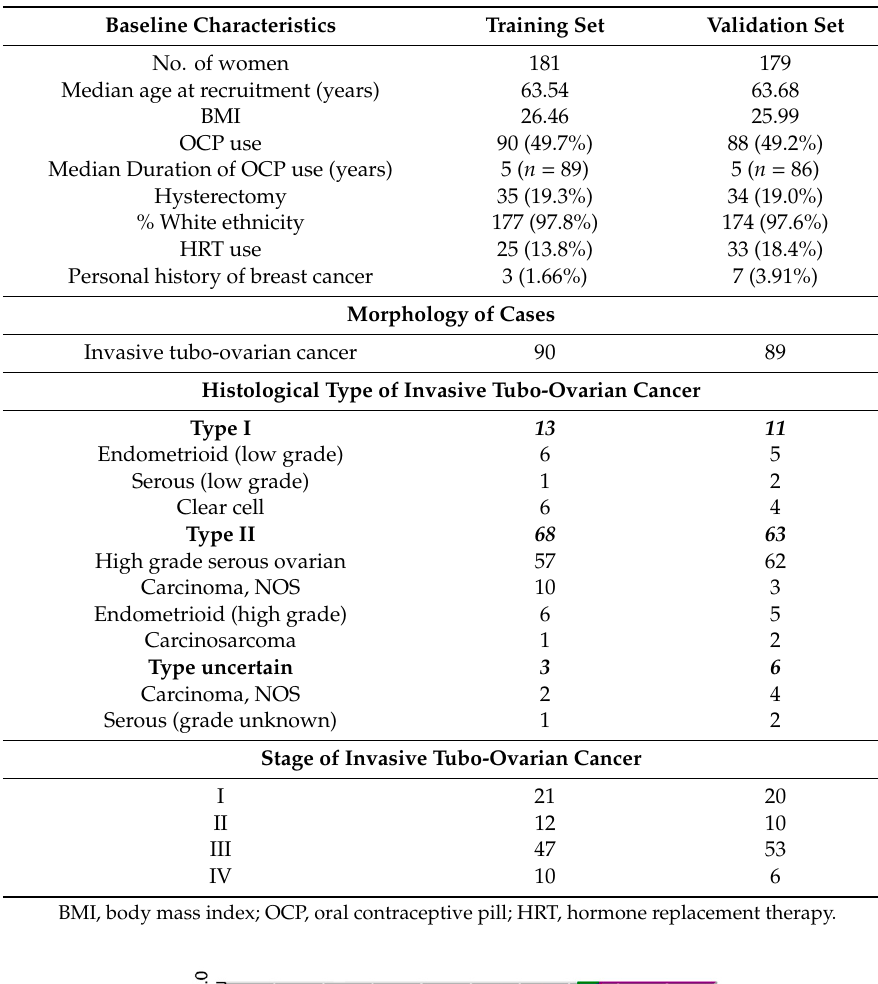
Table 2. Characteristics of cases and controls in training and validation sets.